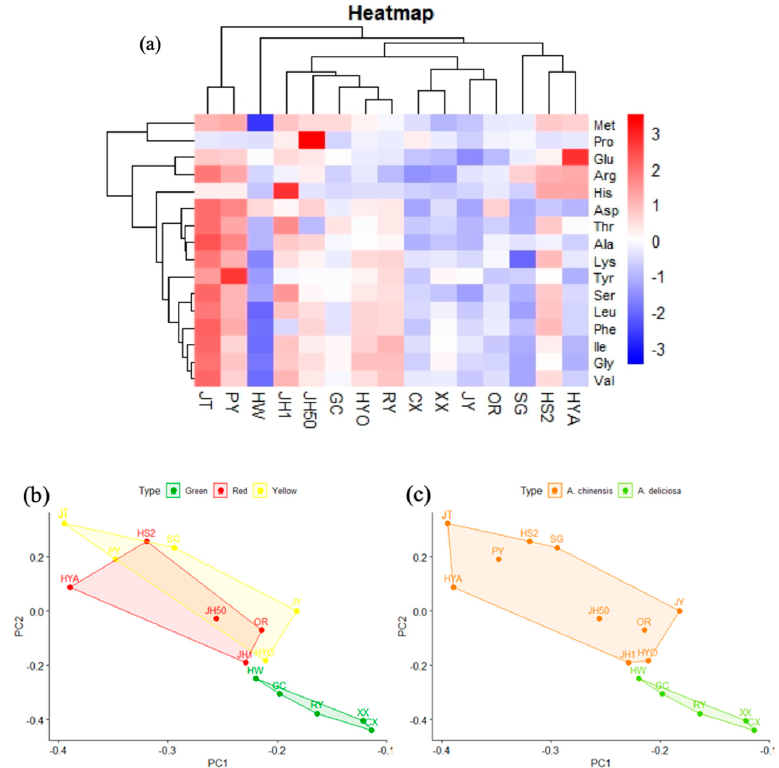
Figure 7. Preliminary analysis of amino acid data. ( a ) Cluster heat map of amino acids in 15 kiwifruit cultivars. ( b ) PCA score plot of amino acids in different flesh colors. ( c ) PCA score plot of amino acids in two species.